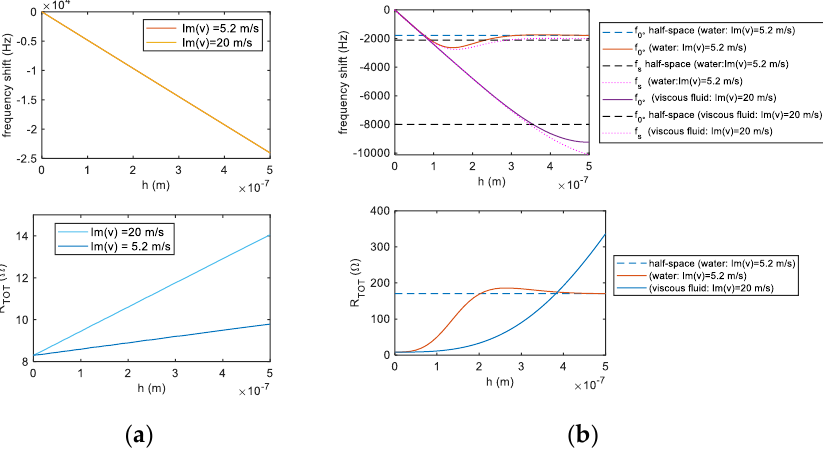
Figure 5. Behavior of the resonance frequency (frequency shift) and motional resistance ( R TOT ) of a quartz load with a film due to the characteristic of the film on the quartz surface; ( a ) results obtained assuming a solid film with the same characteristics simulated to obtain Figure 4a; ( b ) results obtained for a Newtonian fluid with the same density of water and two different viscosities as per legend.